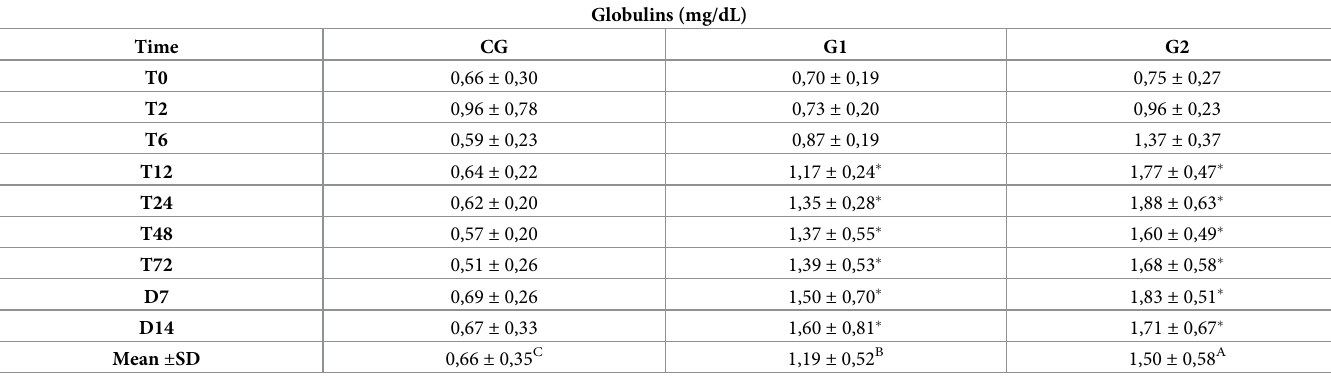
Table 6. Mean and standard deviation (SD) of globulins in the peritoneal fluid of healthy horses (CG) and horses submitted to cecal trocarization with a cecal nee- dle (G1) or a cattle trocar (G2).